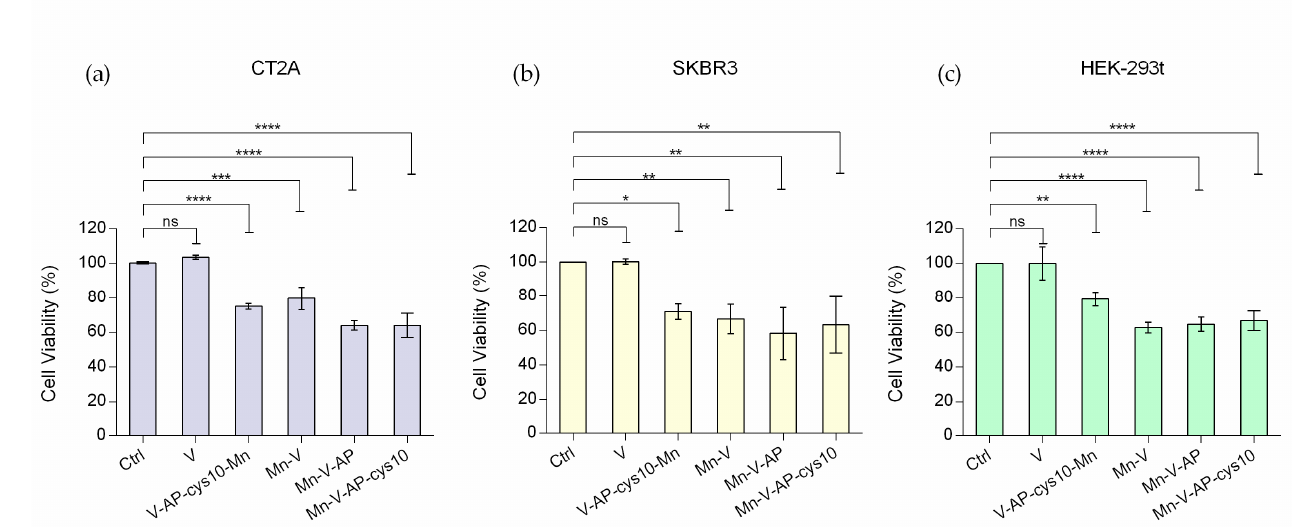
Figure 6. Variation in cell viability depends on the area of functionalization of the material with